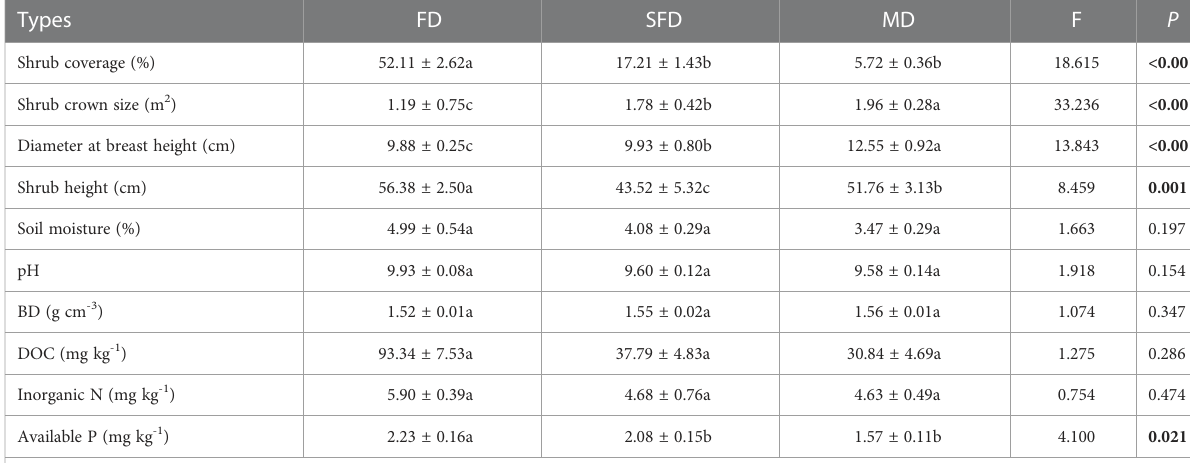
TABLE 2 Characteristics of the plant and soil under three sandy dune